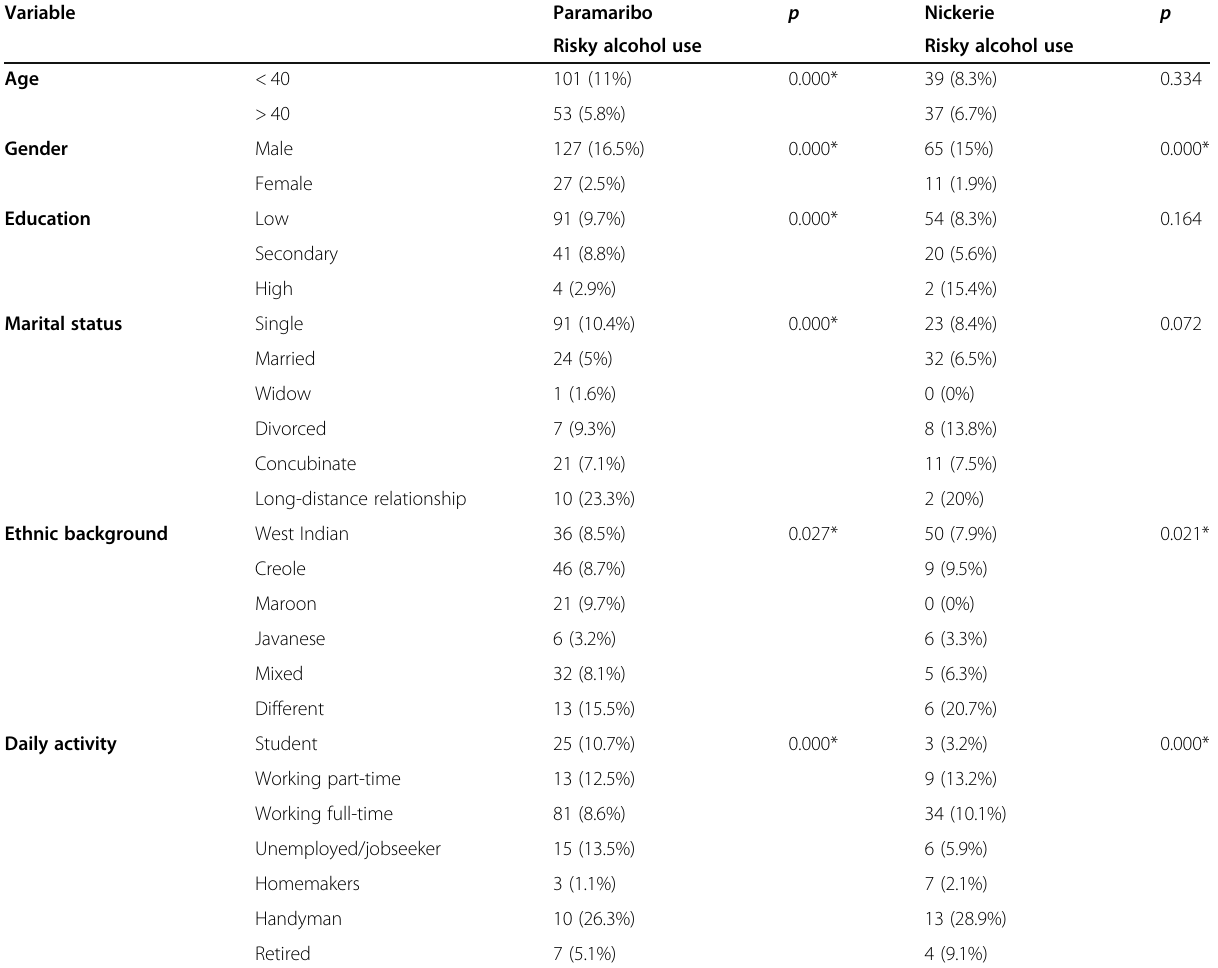
Table 3 Overview of the risk for addiction in the two samples for the different demographic categories